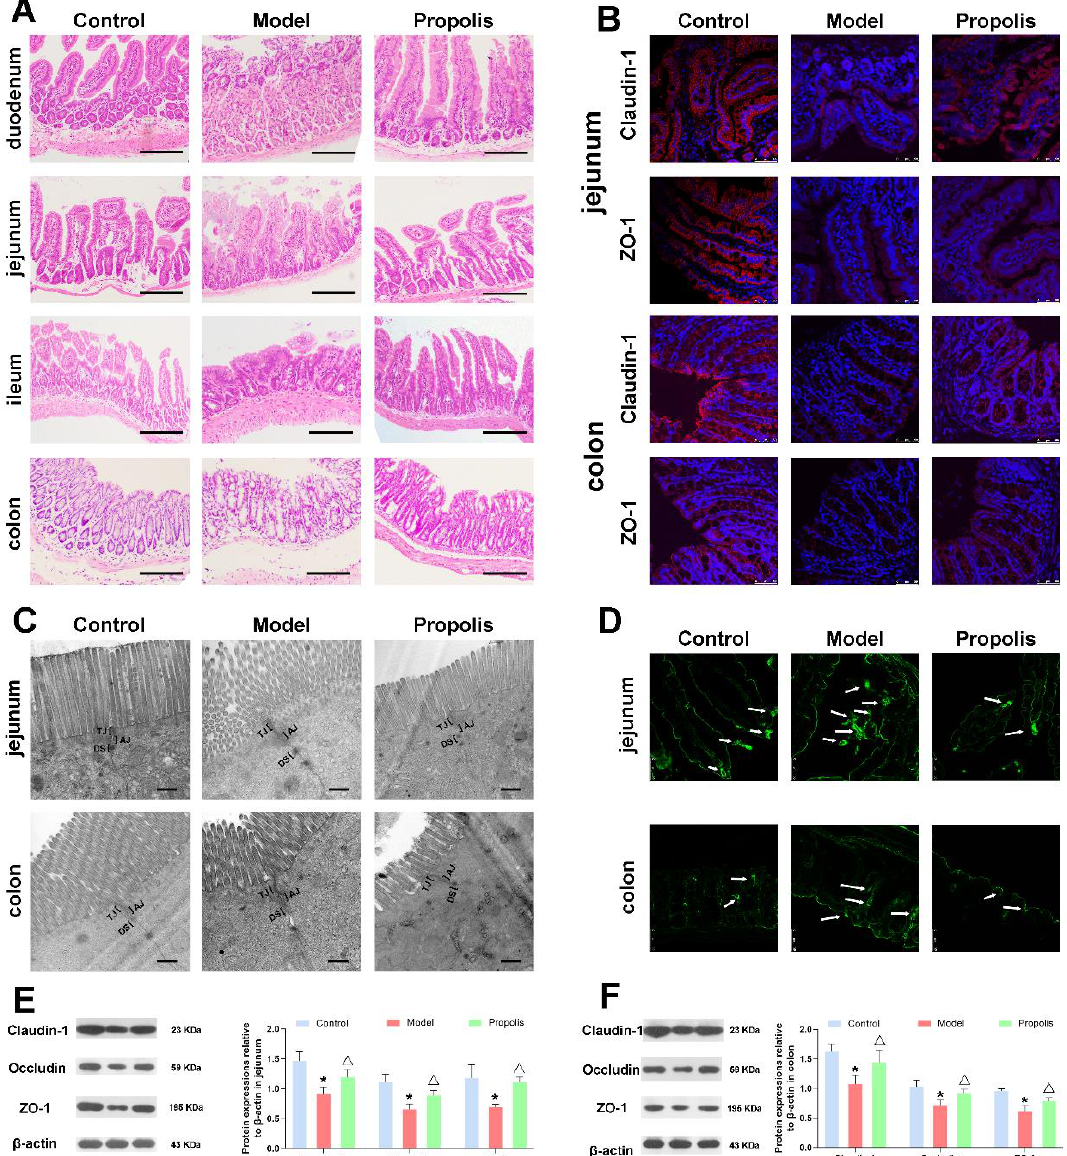
Figure 4. Effects of propolis on intestinal mucosal barrier function. ( A ) Pathological changes of duodenum, jejunum, ileum and colon according to HE staining. Scale bar = 200 µ m. ( B ) Immunofluorescence detection of tight junctions related proteins Claudin-1 (red fluorescence) and ZO-1 (red fluorescence) in tissues of the jejunum and colon. Nuclei were counterstained with DAPI (blue fluorescence). Scale bar = 50 µ m. ( C ) The ultrastructure of jejunum and colon was observed by transmission electron microscope. Scale bar = 500 nm. ( D ) Biotin tracer assay in jejunum and colon. The green fluorescence signals indicate biotin distribution; the white arrows indicate tracer leakage. Scale bar = 50 µ m. ( E , F ) Expressions of Claudin-1, Occludin, and ZO-1 proteins in jejunum ( E ) and colon ( F ) examined by Western blotting. * Denotes p < 0.05 vs. control group; (cid:52) p < 0.05 vs. model